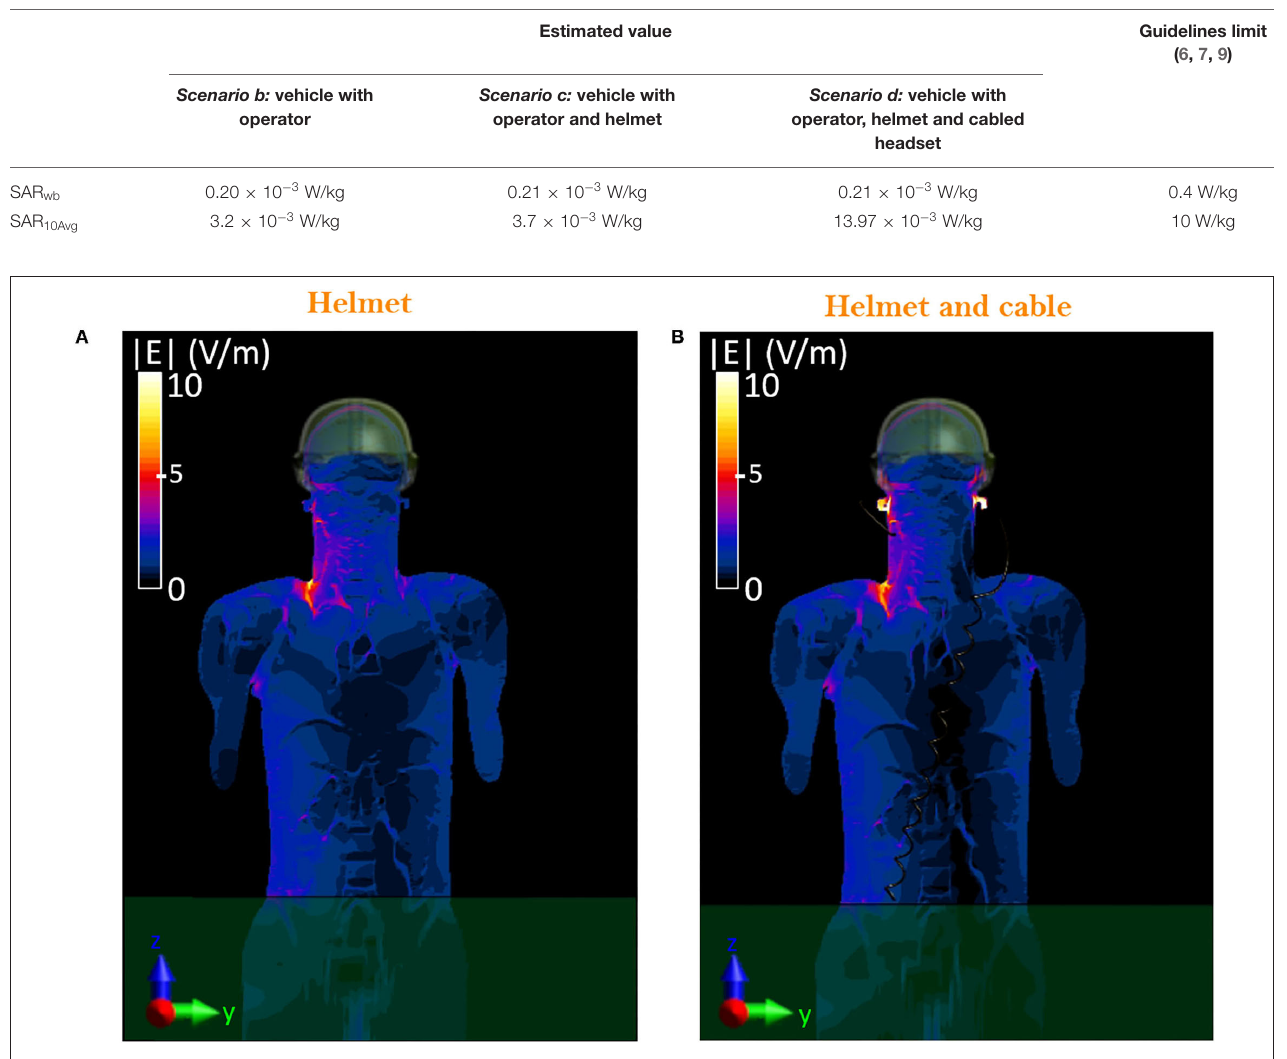
TABLE 2 | Comparison between the estimated SAR values in the three exposure scenarios that include the operator model and guidelines limits.